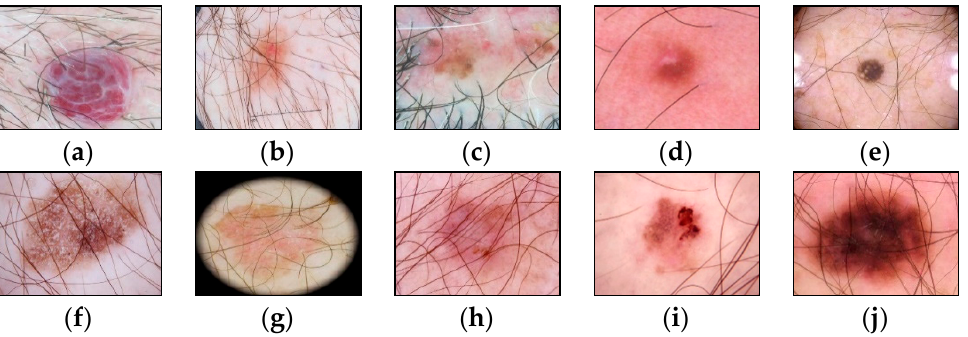
Figure 2. Examples of pigmented skin lesions images with hairy structures: ( a ) vascular lesions; ( b ) nevus; ( c ) solar lentigo; ( d ) dermatofibroma; ( e ) seborrheic keratosis; ( f ) benign keratosis; ( g ) actinic keratosis; ( h ) basal cell carcinoma; ( i ) squamous cell carcinoma; ( j ) melanoma.